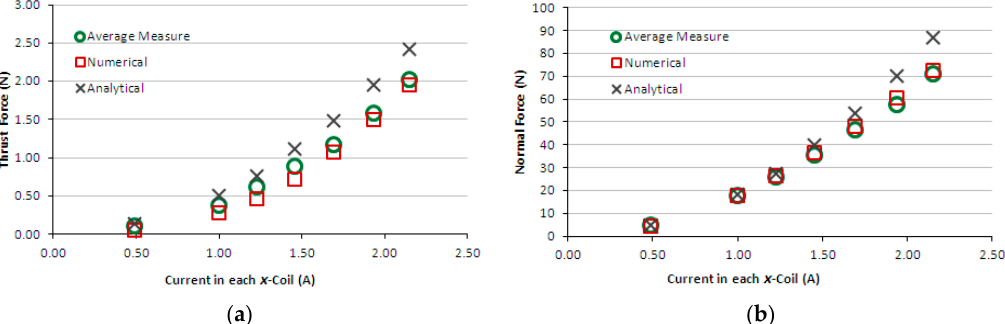
Figure 13. Case 3: ( a ) thrust force and ( b ) normal force produced by the induction planar actuator with only the x -winding excited.